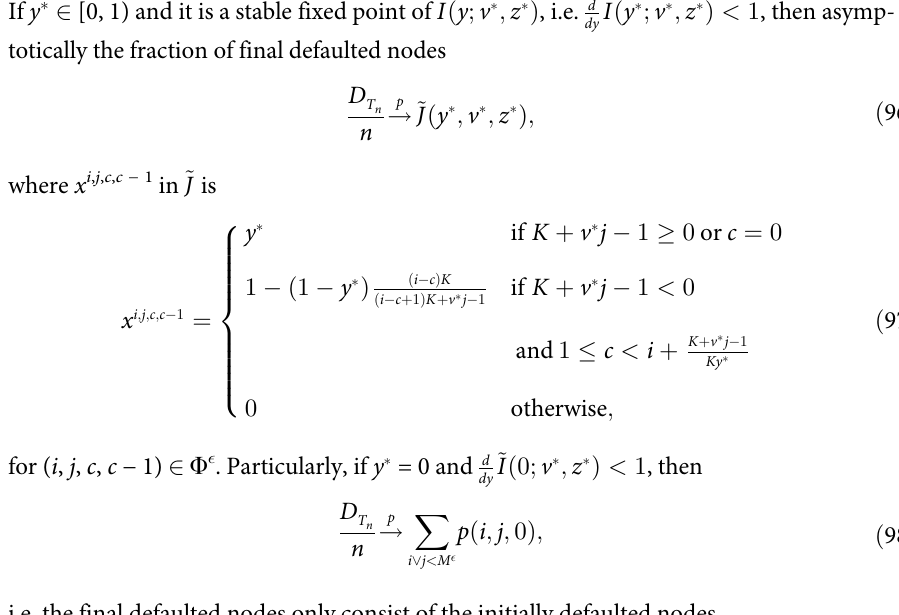
Algorithm 1 . Solving Eq (86)